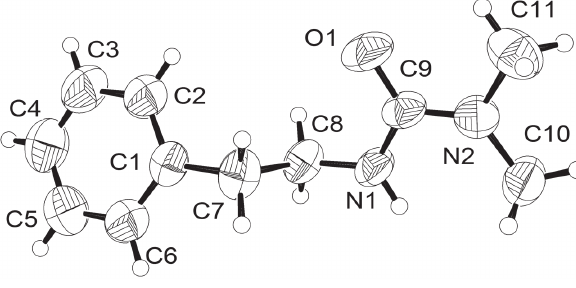
Table 1: Data collection and handling.